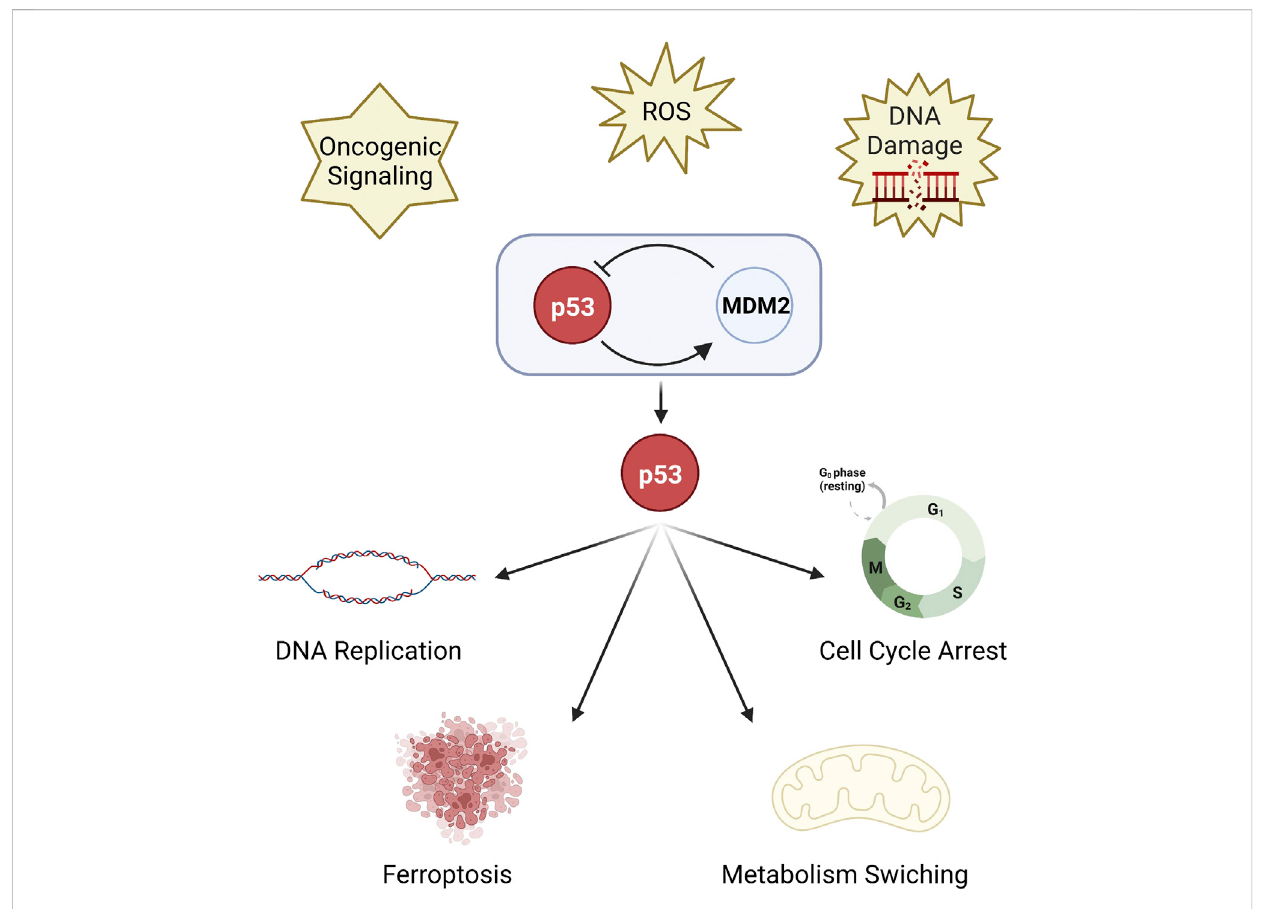
The functionof p53.p53 isakeyregulatorofDNAreplicationstress andDNArepair.p53 isinhibitedby MDM2 protein, but upregulated understress. Upregulated p53 mediates cell cycle arrest and DNA replication, metabolism switching, and